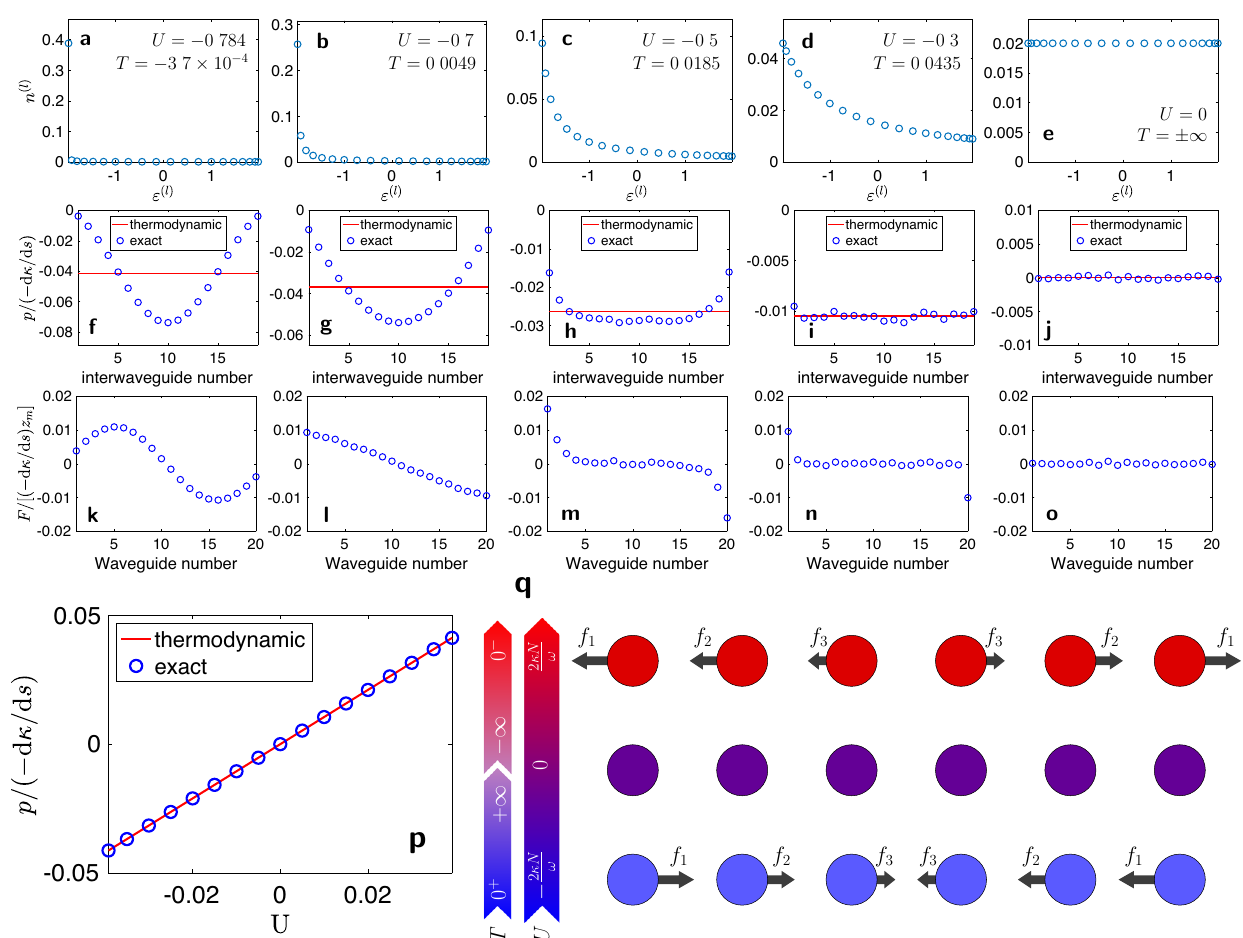
Fig. 3 Pressure in a linear arrangement of waveguides having zero-boundary conditions. Distributions of pressure and applied forces in a one- dimensional photonic lattice with M = 20 waveguides, zero-boundary conditions, and power N = 0.4. In the fi rst row ( a – e ), we see the power occupation numbers which obey Rayleigh-Jeans distributions. In the second row ( f – j ), the interwaveguide pressures p j , obtained by taking an ensemble average (blue circles), and the thermodynamic pressure (red line) are presented and compared. In the third row ( k – o ), we depict the total force per unit of propagation length applied to each particular waveguide of the lattice. In the fi ve columns, the internal energy is increased from the condensation limit ( fi rst column) to U = 0, where the Rayleigh-Jeans distribution becomes uniform (as T → ± ∞ ). In the fi rst three rows, we focus on the case of negative energies. Results with U > 0 can be directly derived from those with negative U via a simple transformation, as described in the main text. p The thermodynamic pressure is in p excellent agreement with the average value of the intewaveguide pressures p ¼ ð 1 = ð M (cid:2) 1 ÞÞ ∑ M (cid:2) 1 j j . q Schematic of the forces exerted within the lattice. ¼ 1 When U < 0 or T > 0 (top), the forces are attractive, whereas when U > 0 or T < 0 (bottom), the forces are